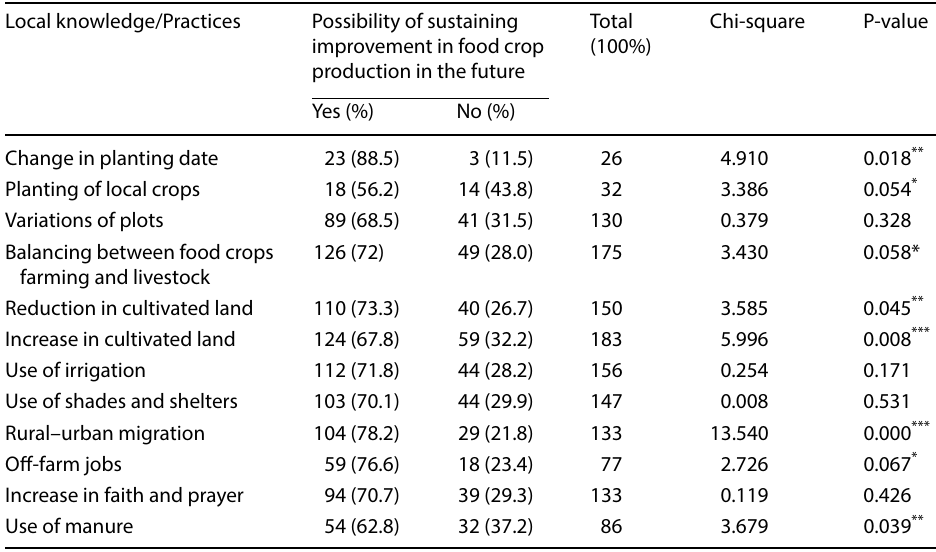
Table 5 Local practices and perceived improvement in food crops farming in the